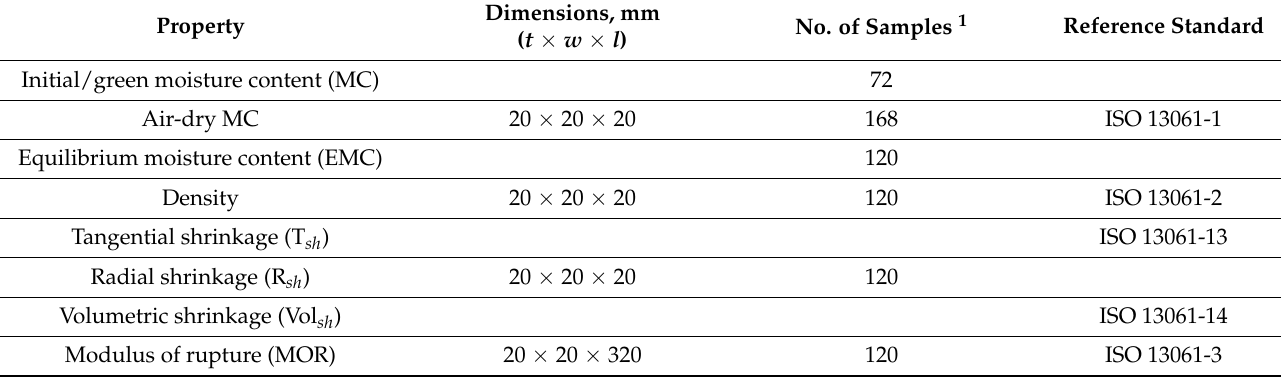
Table 2. Size and number of test samples for physical and mechanical tests according to respective standards.